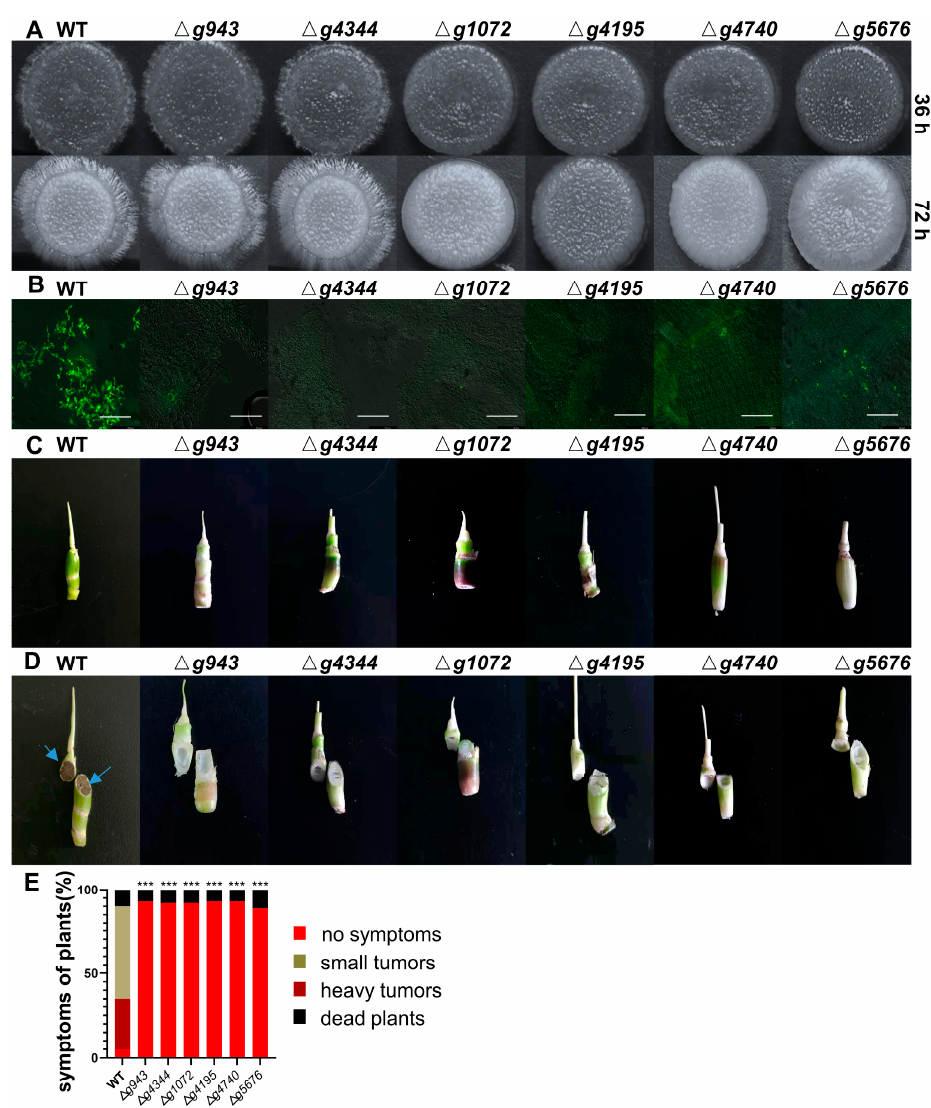
Figure 6. Role of secreted proteins in virulence. Deletion mutants of g943 , g4344 , g1072 , g4195 , g4740 , and g5676 were studied, and wild-type (UeT14 and UeT55) was set as positive control. ( A ) Typical colony mating morphology of deletion mutants under a stereomicroscope at 36 h and 72 h after culture. ( B ) Observation of infection status in the stem. The mixtures of compatible strains were injected into the stems of Z. latifolia . Samples were collected at 30 days post-inoculation, stained with WGA-FITC, and analyzed by laser scanning confocal microscopy. Green fluorescence indicates mycelia of U. esculenta . The scale bar represents 75 μ m. ( C ) The symptom of representative plants at 90 days post-inoculation. ( D ) The cross-section of the stem of representative plants at 90 days post-inoculation (The blue arrows refer to teliospore produced by U. esculenta ). ( E ) The symptoms of inoculated host plants were scored 90 days later according to severity (number of replications = 100). Statistically significant difference with wild-type control: *** p <